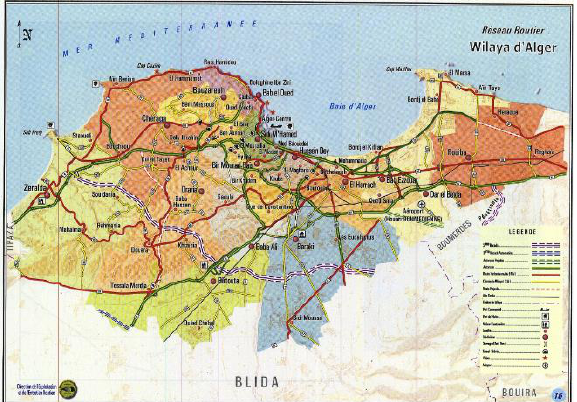
Figure 3. Road transport network in Algiers. Source: Road Operations and Maintenance